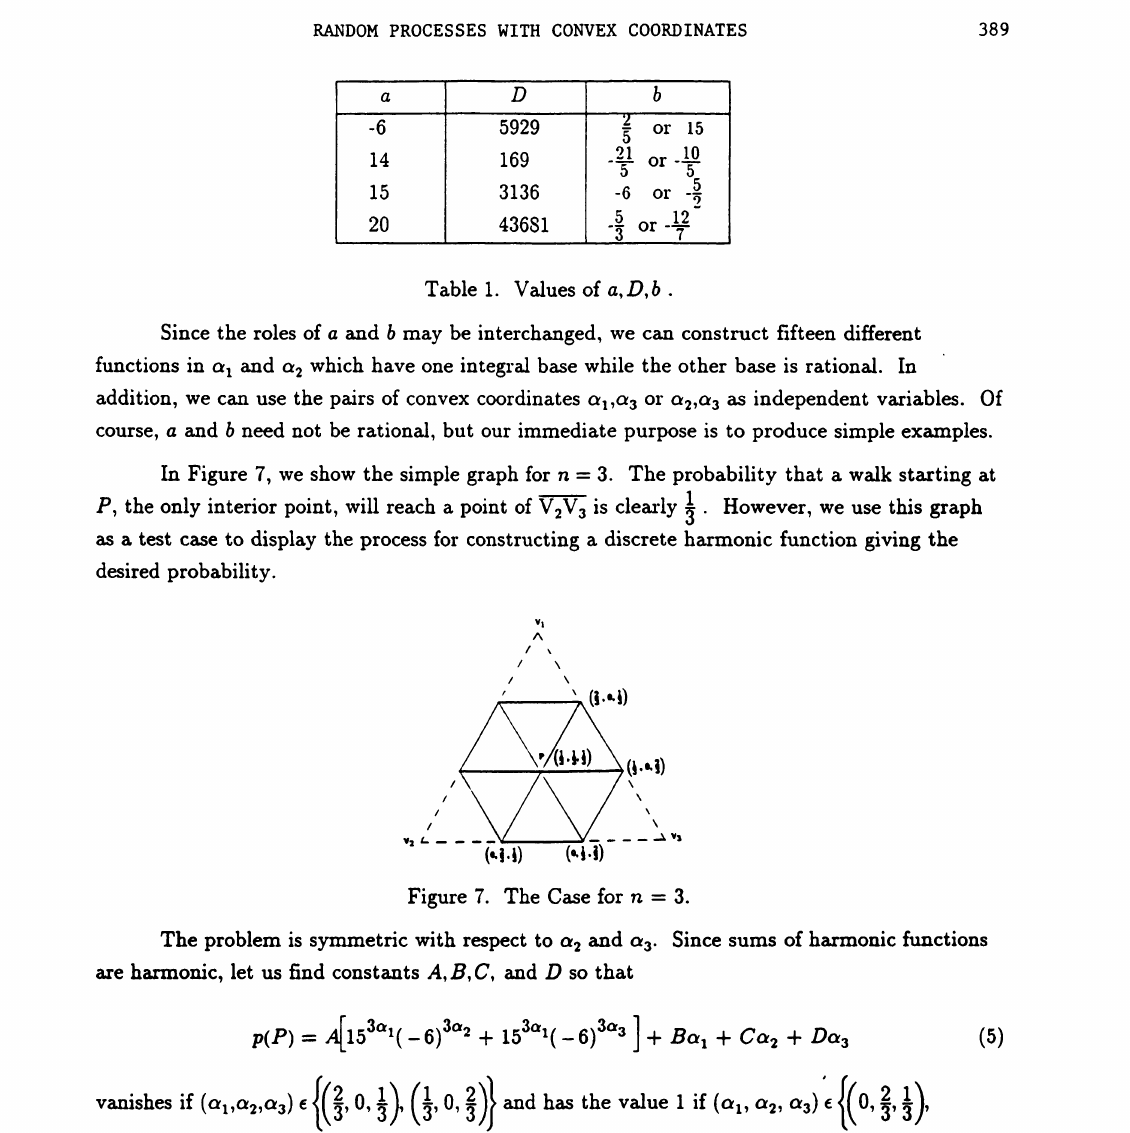
Figure 7. The Case for n